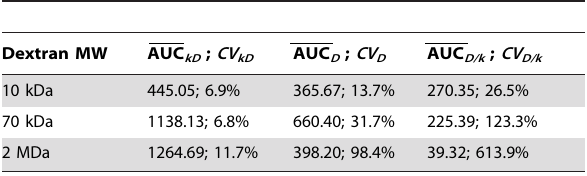
Table 3. The average AUC and CV values corresponding to different interstitial diffusivity of carriers shown in Figure